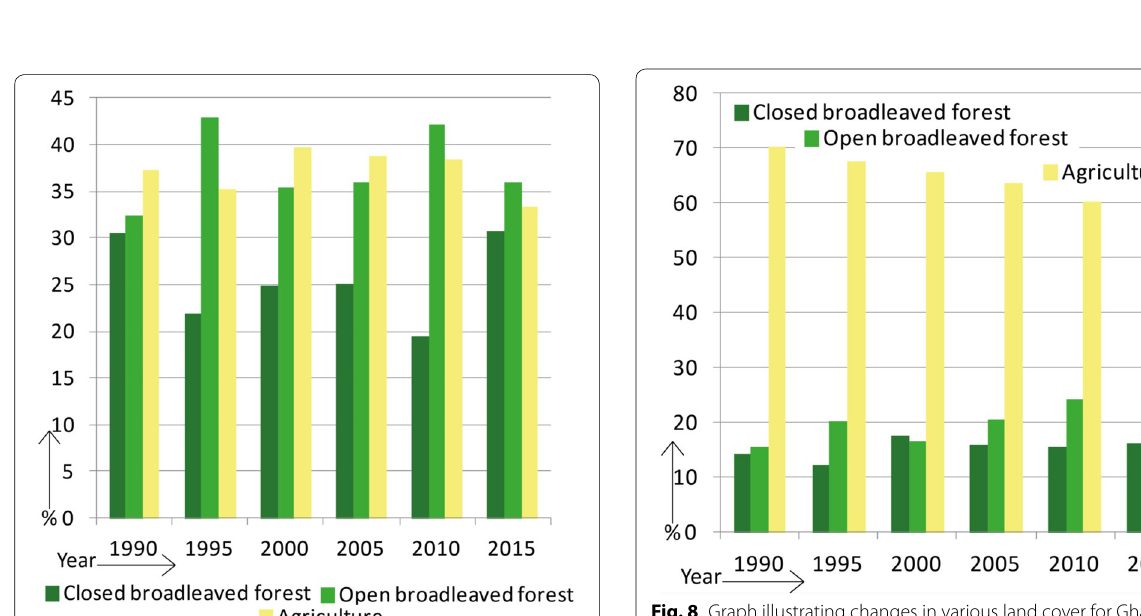
Fig. 7 Figure represents changes in various land cover for Guhe Khola watershed